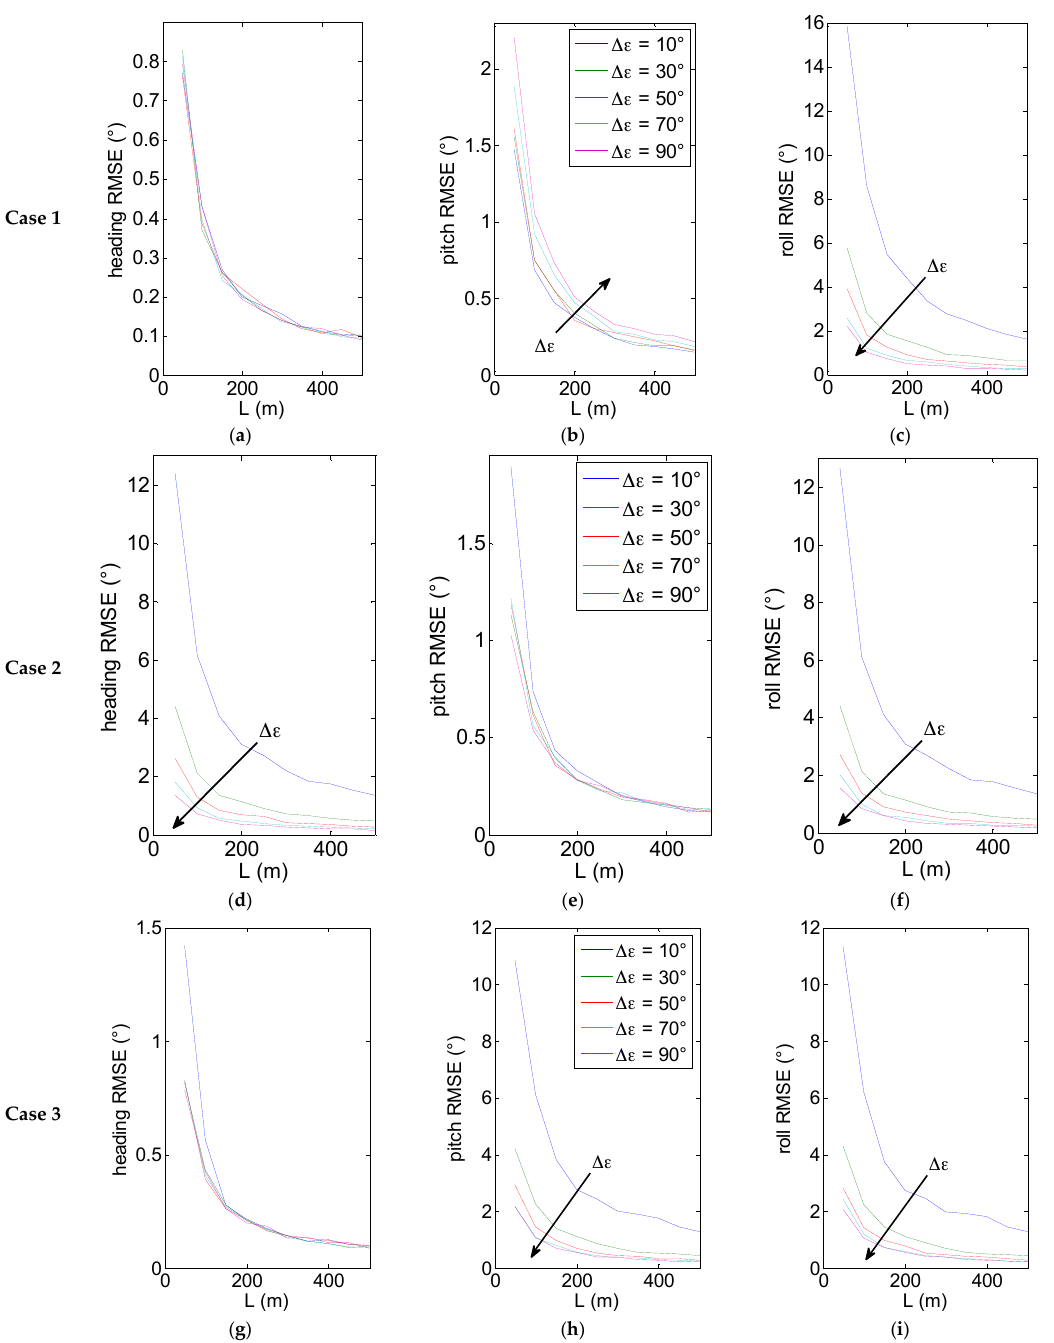
Figure 4. Attitude root mean square errors (RMSE) as a function of baseline L, for different values of angular separation. Case 1 ( a – c ) heading pitch and roll RMSE for μ = ε c = 0 ° ; Case 2 ( d – f ) heading pitch and roll RMSE for μ = 45° and ε c = 0°; Case 3 ( g – i ) heading pitch and roll RMSE for μ = 0° and ε c = 45°.